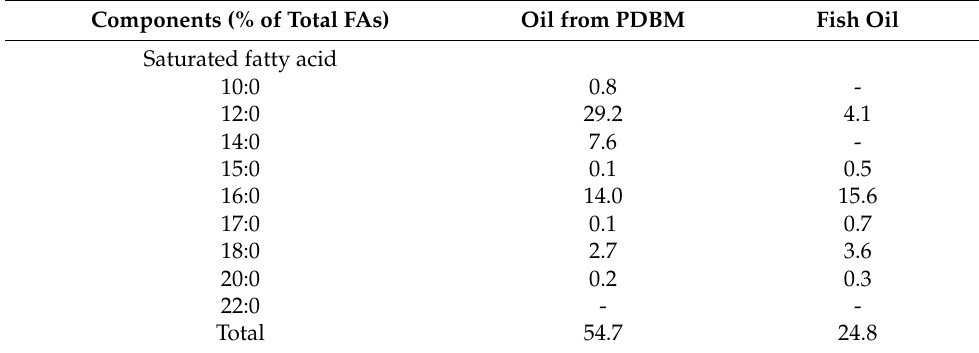
Table 5. Fatty acid (FA) profile of black soldier fly larvae meal in this study. Components (% of Total FAs) Oil from